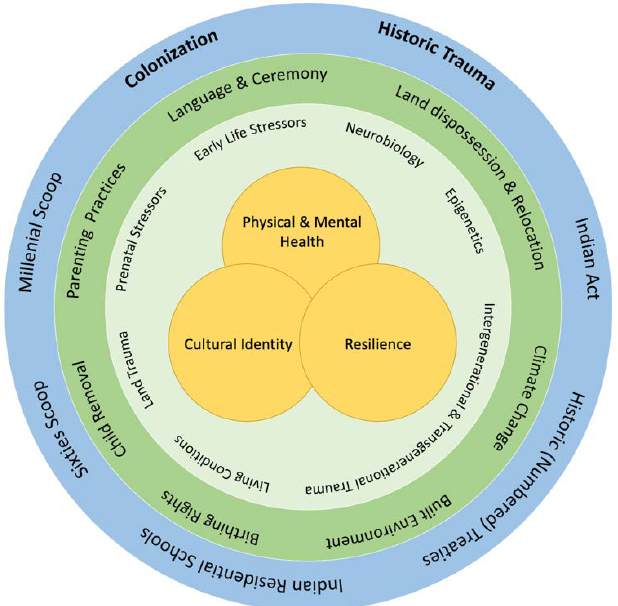
Figure 1. The determinants of health framework we are presenting to outline our understanding of the genocidal impacts of Canadian policies regarding Indigenous Peoples. The outer circle represents the federal policies and programs; the adjacent inner circle constitutes the targeted actions that were taken to achieve the goals of the policies, affecting the relational, cultural, and environmental context of Indigenous Peoples. As a result, these actions gave rise to processes (third inner circle) that have contributed to the health and well-being of Indigenous Peoples.